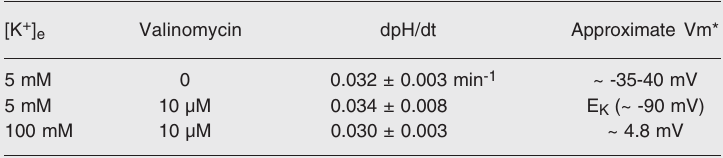
Table 2. pH recovery rates after an acid pulse at different external [K + ] concentrations in the presence and absence of